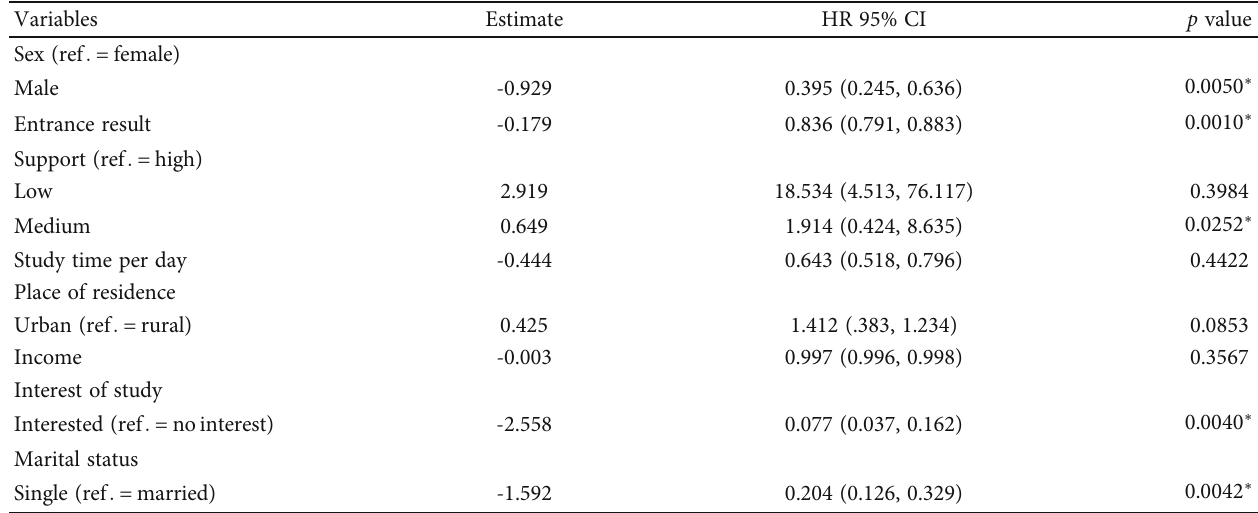
Table 3: Parameter estimates, HR, and 95% CI under the survival modeling